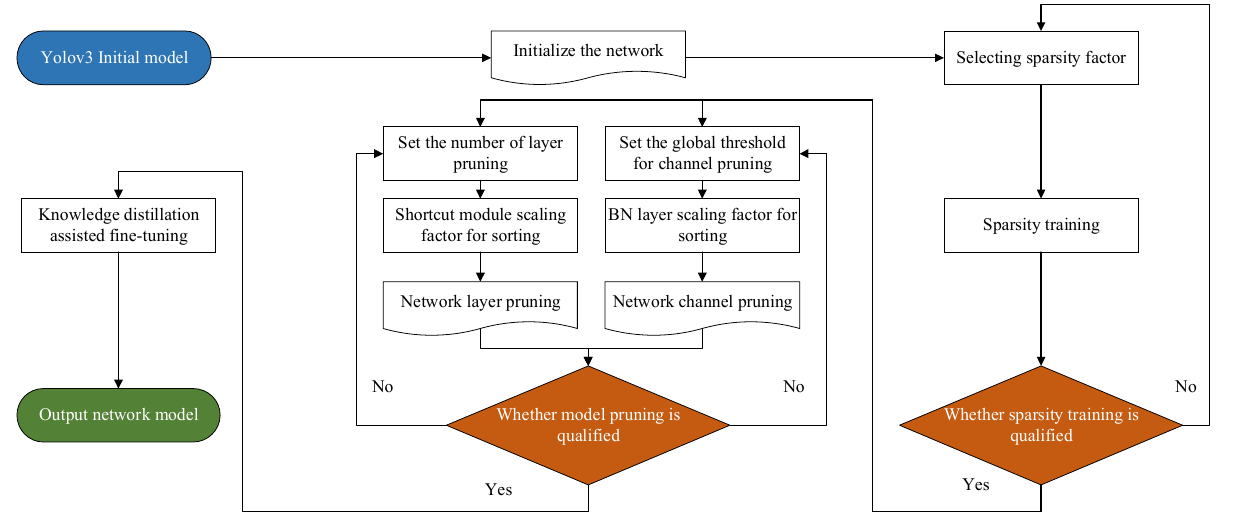
Figure 5. The flow chart for model compression.